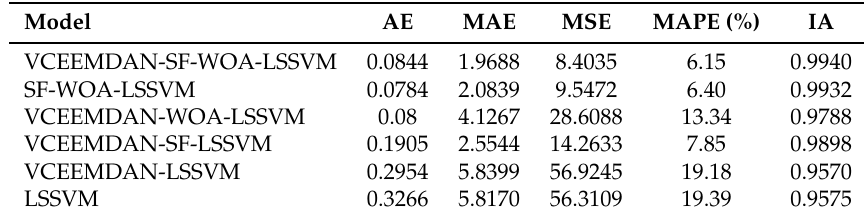
Table 4. Experiment I forecasting results in Yibin.